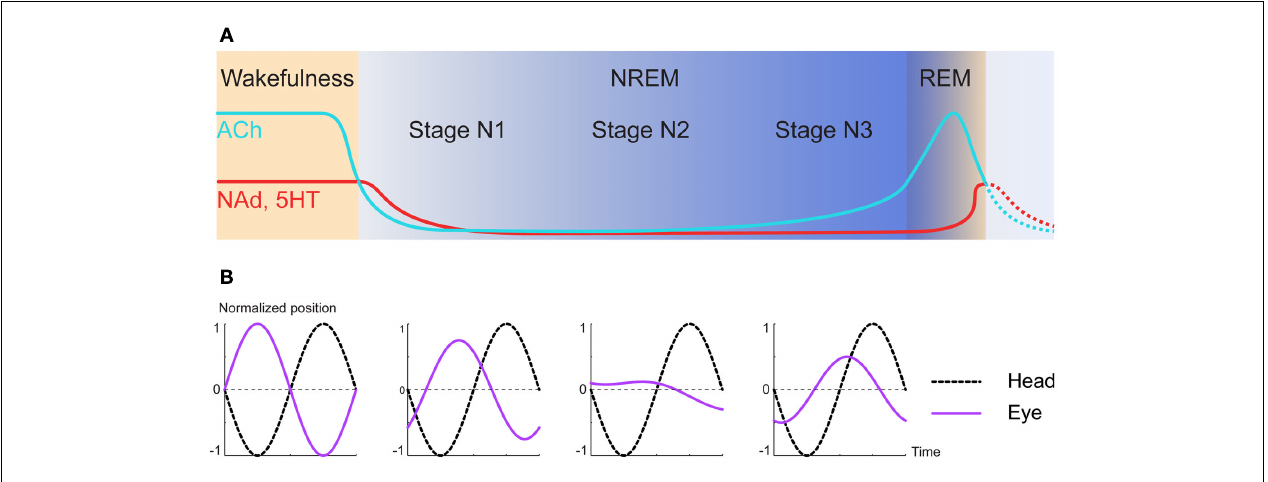
movements in response to head rotations during vestibulo-ocular reflex in dark. Both the amplitude and phase of the eye movements generated in response to sinusoidal stimulations are increasingly altered as deeper levels of sleep are reached. (Adapted from Jones and Sugie, 1972; and Kasper et al.,